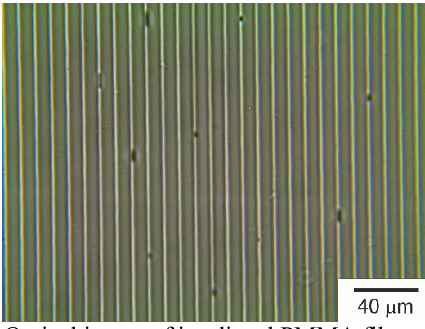
Fig. 3. Optical image of irradiated PMMA film on